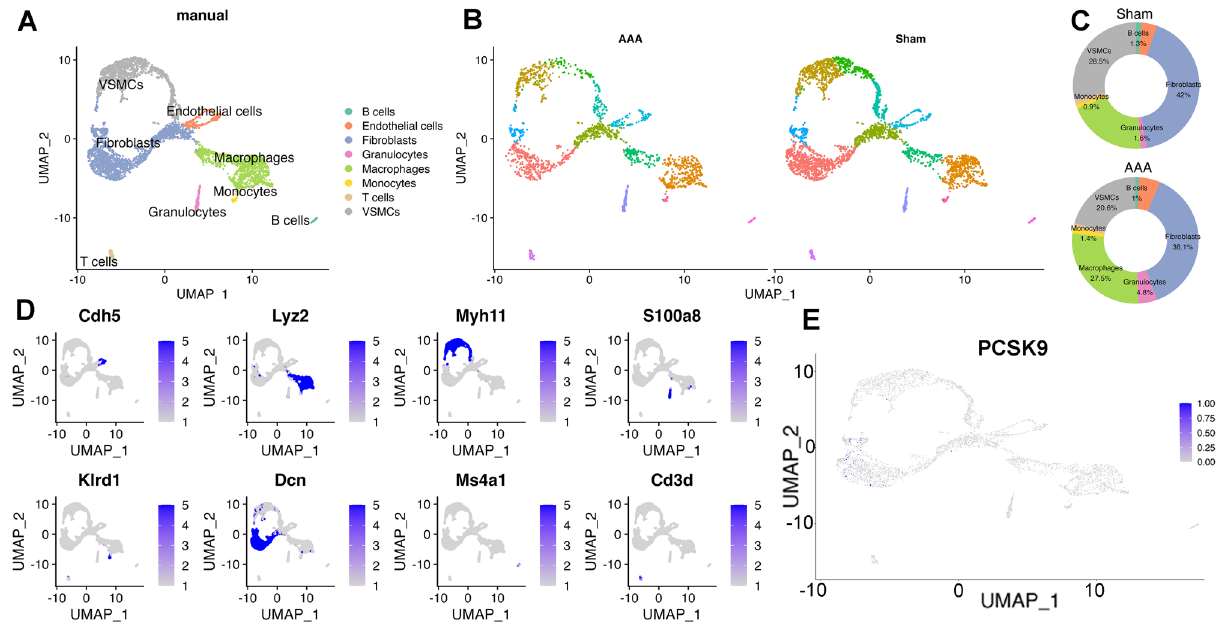
Figure 3. Identification of the cell composition changes in AAA and cellular localization of PCSK9 by scRNA- seq data (GSE164678) analysis. ( A ) Separate eight cell clusters according to uniform manifold approximation and projection (UMAP) plot. ( B ) Cell distributions in AAA and sham samples are shown in UAMP. ( C ) Pie plot showing the percentages of each cell population in AAA and sham groups. ( D ) Top marker genes of these eight cell clusters. ( E ) UMAP plots showing that PCSK9 was mainly expressed in fibroblasts in